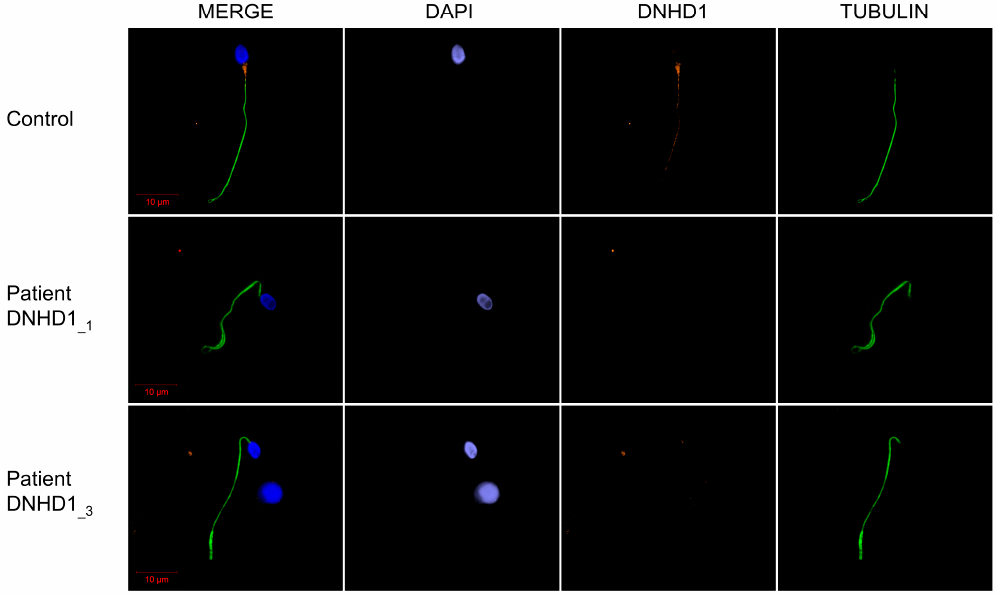
Figure 2. DNHD1 immunostaining of sperm cells from patients with DNHD1 mutation. Sperm cells from a fertile control individual and the two DNHD1 _1 and DNHD1 _3 patients stained with anti-DNHD1 (orange) and anti-acetylated tubulin (green) antibodies. DNA was counterstained with DAPI (blue). In the fertile control, DNHD1 was present throughout the entire flagella with a higher intensity in the midpiece of the sperm flagellum. Conversely, DNHD1 was totally absent from all sperm cells from both individuals DNHD1 _1 and DNHD1 _3 . Scale bars: 10 µm.